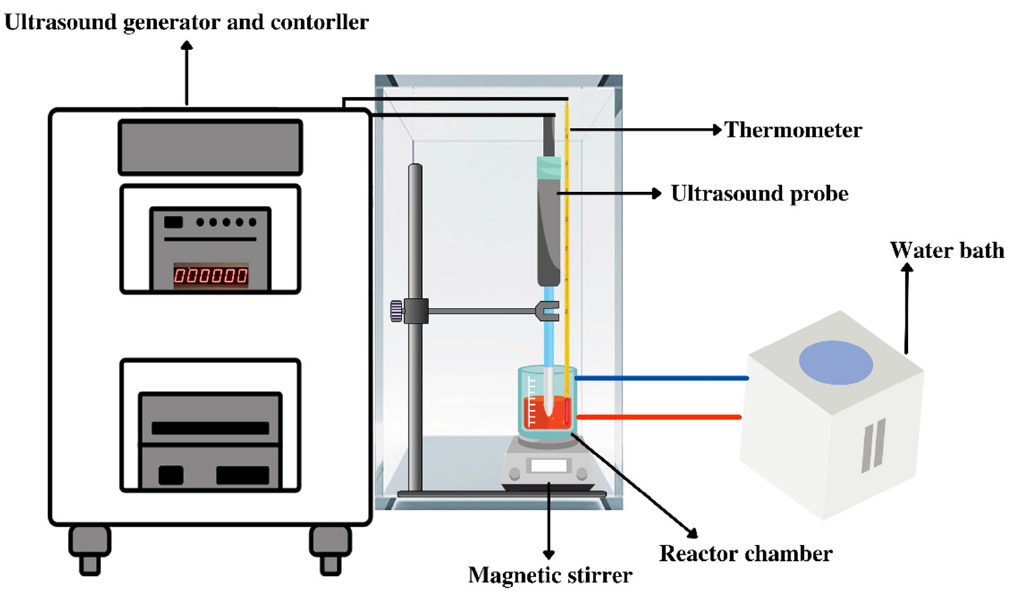
Figure 3. Simplified schematic of ultrasound assisted extraction of polyphenols.